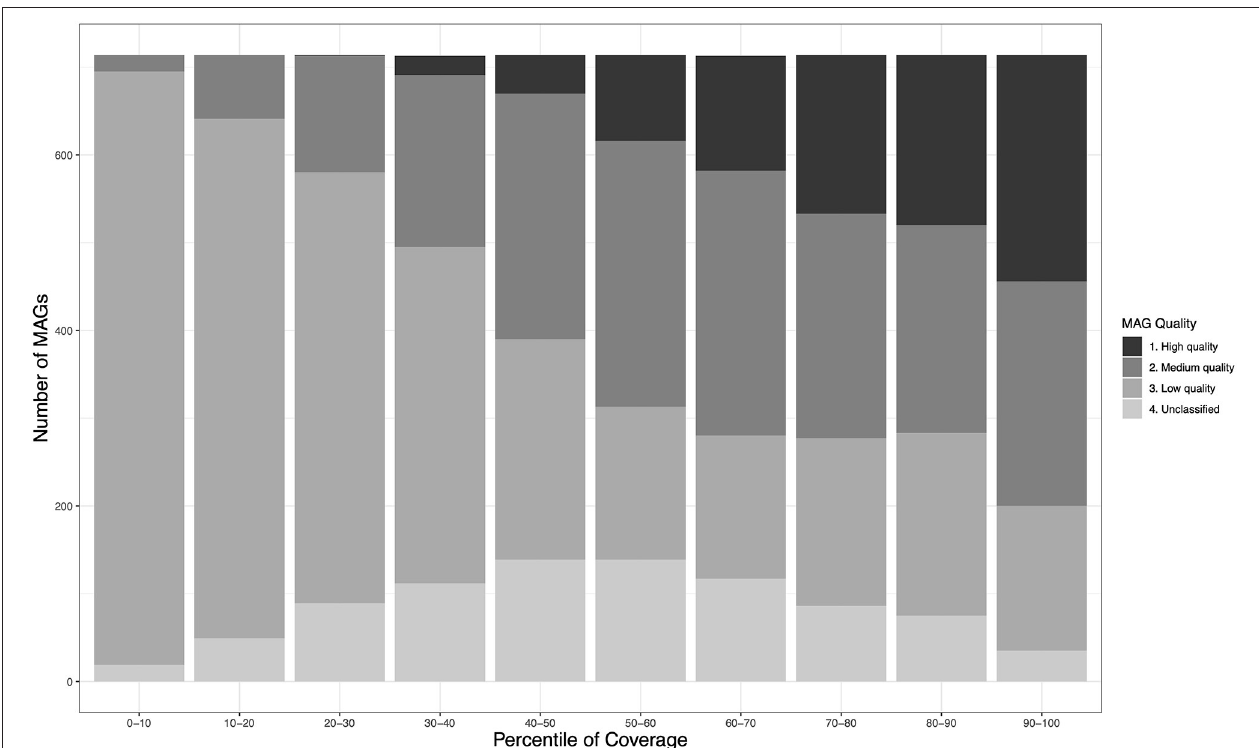
FIGURE 1 | Relationship between genome quality and relative abundance within the MetaBAT2-derived MAG catalogs obtained in this study. Relative abundance is inferred using a normalised measure of coverage, permitting comparison of mean MAG coverage among the three different assembly-binning workflows (see Table 1 ). Within each decile of the normalised coverage distribution, the numbers of MAG meeting each of the four MIMAG-derived quality levels is shown.